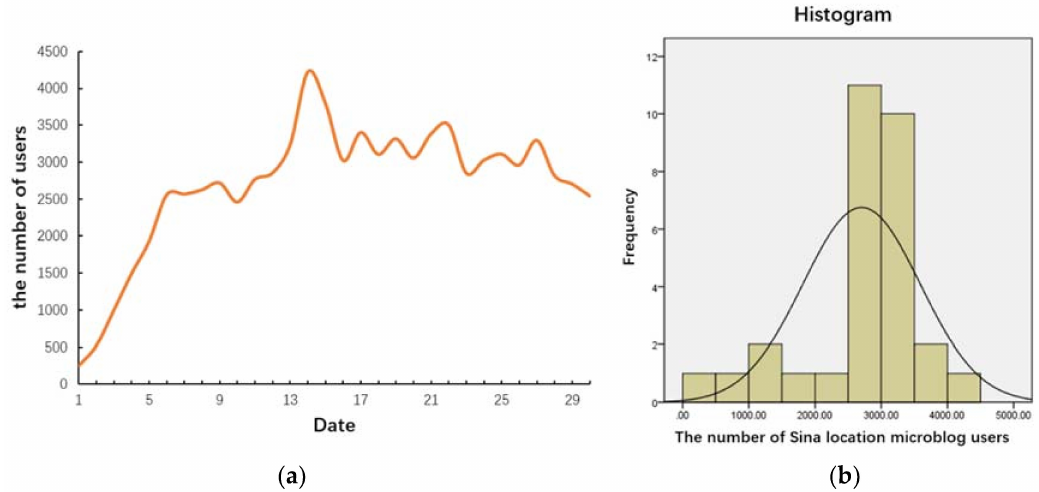
Figure 3. Variation in the number of Sina Location Microblog users in June 2014: ( a ) the number of users per day; ( b ) the histogram of the data.